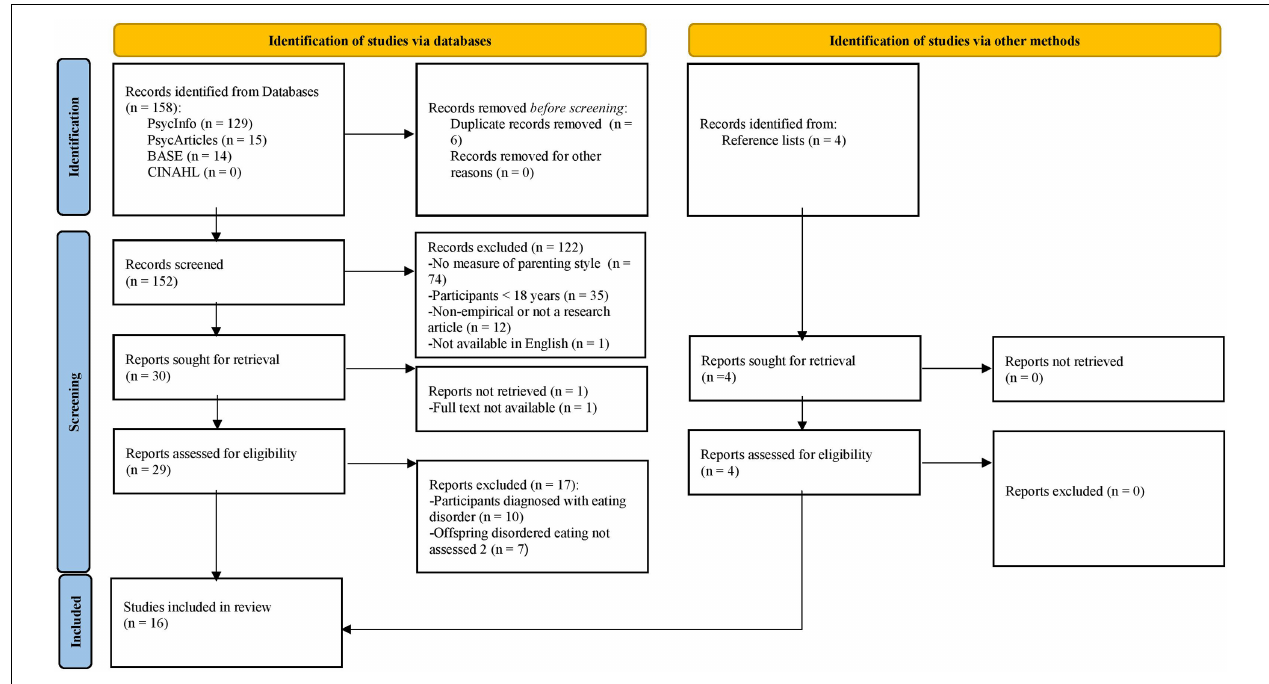
FIGURE 1 | PRISMA 2020 flow diagram for new systematic reviews which included searches of databases and other sources (Page et al.,